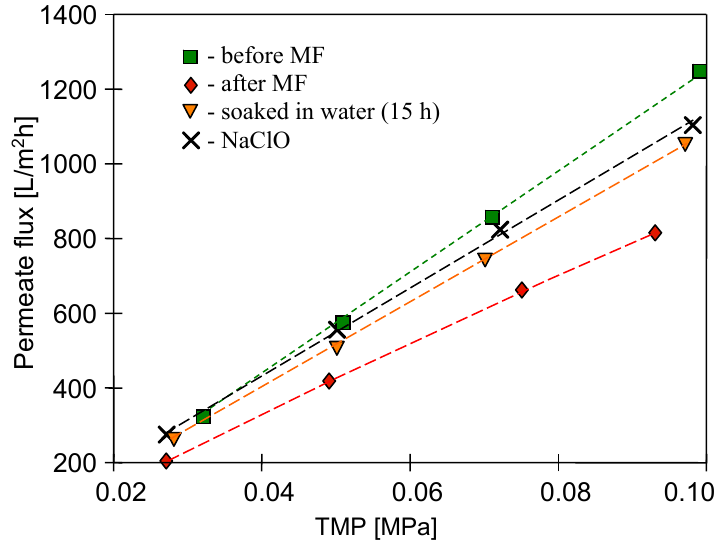
Figure 11. Variations in permeate flux during membrane cleaning after MF of model oily wastewater (C F = 90 mg/L, T = 50 °C).